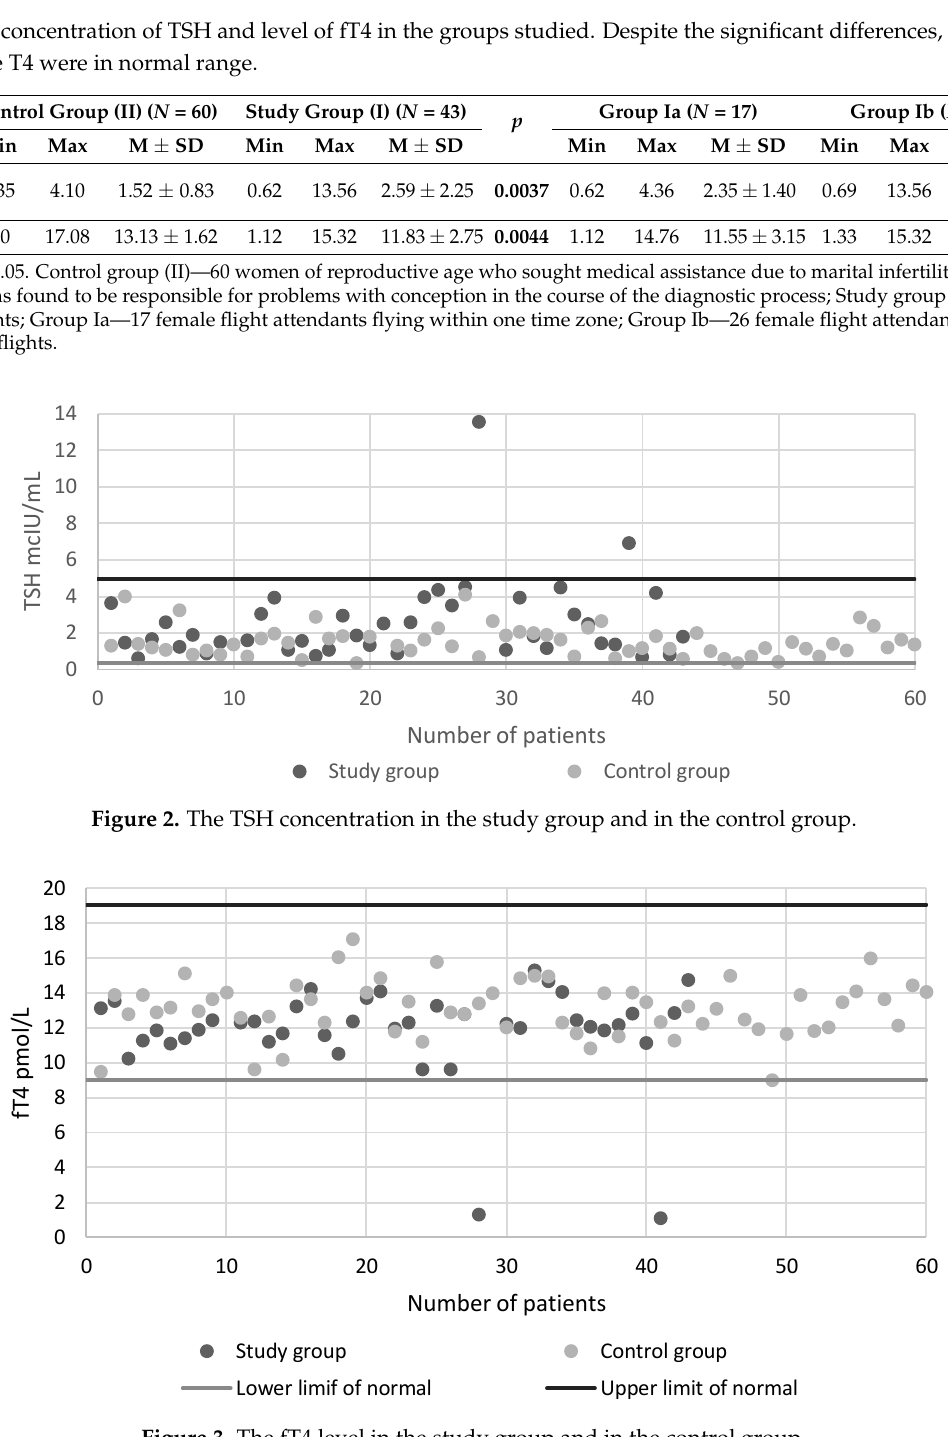
Figure 3. The fT4 level in the study group and in the control group.